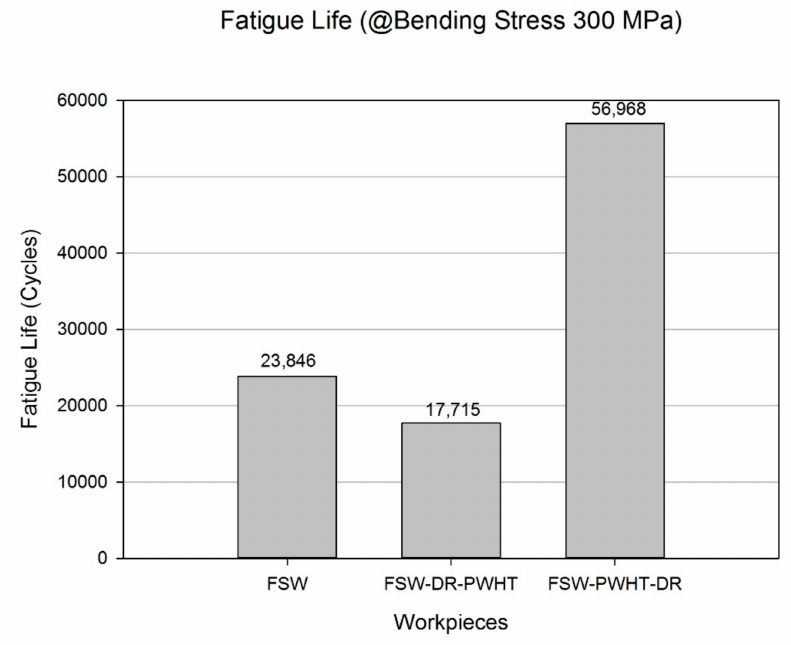
Figure 18. Fatigue life of the friction stir welded workpiece.